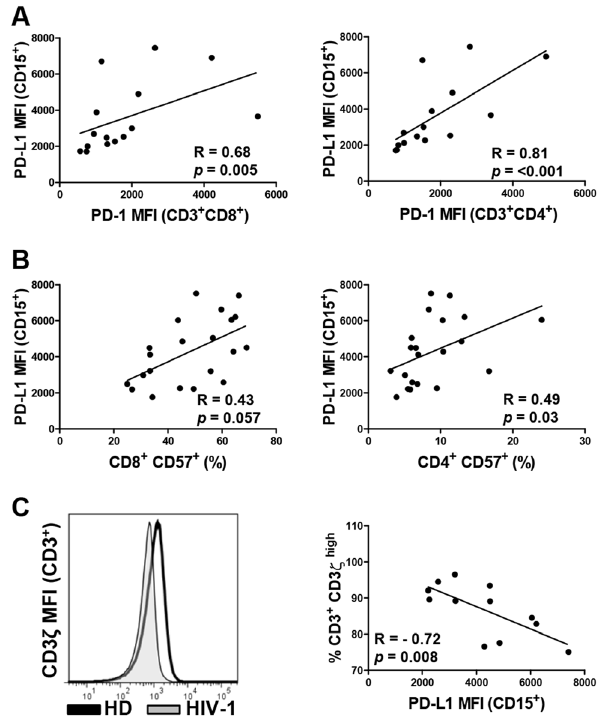
Figure 4. PD-L1 expression on neutrophils correlates directly with PD-1 and CD57 expression on T cells and inversely with the expression of CD3 f chain on T cells. CD3 + CD8 + and CD3 + CD4 + T cells from PBMCs were stained for PD-1 (A), CD57 (B), and CD3 f (C). A) Correlation between PD-1 expression on CD8 + and CD4 + T cells and PD- L1 expression on neutrophils in blood. B) Correlation between the percentage of CD57 + cells of total CD3 + CD8 + and CD3 + CD4 + T cells and PD-L1 expression on neutrophils in blood. C) Flow cytometry analysis of the expression of CD3 f chain on T cells and correlation between the percentage of CD3 + CD3 f high population and PD-L1 expression on neutrophils. Spearman’s rank correlation coefficients (R) and p values are indicated for each correlation; lines represent linear regression analysis.